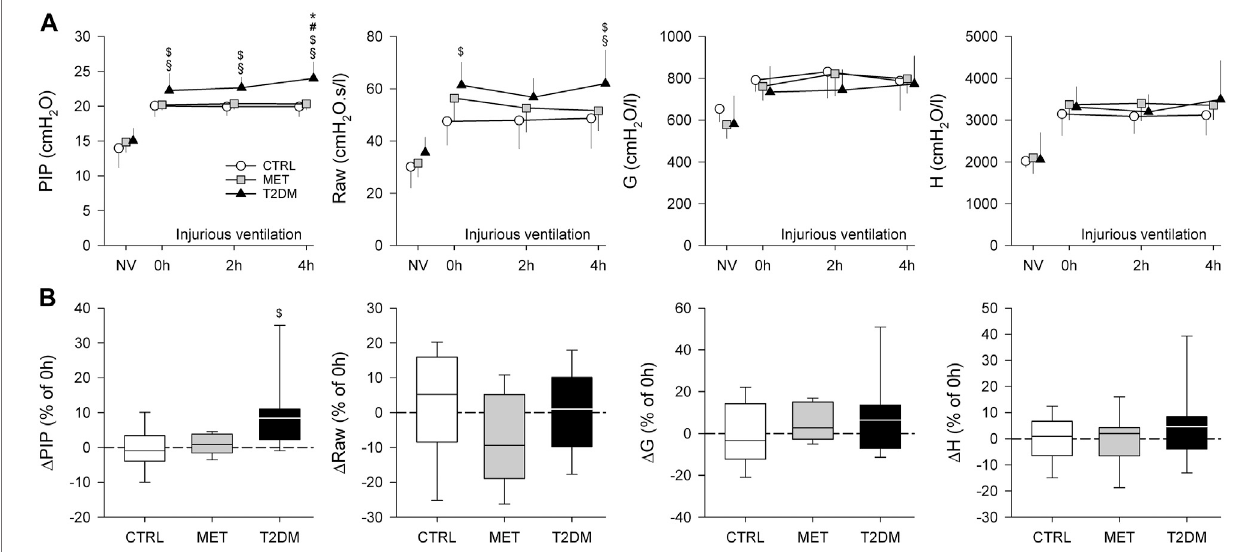
FIGURE 4 | Peak inspiratory pressure (PIP), airway and viscoelastic respiratory tissue mechanical parameters obtained during volume-controlled ventilation with physiological parameters (NV) and injurious ventilation in control rats (CTRL), in rats with metformin-treated type 2 diabetes (MET), and in rats with untreated type 2 diabetes (T2DM). (A) : Absolute changes in mean values ±standard deviation (SD). (B) : Changes after 4 h of injurious ventilation values relative to the values obtained at 0 h. * p < 0.05 vs. 0 h; # p < 0.05 vs. 2 h; $ p < 0.05 vs. CTRL; § p < 0.05 vs. MET. Abbreviations: PIP, Peak inspiratory pressure; Raw, airway resistance; G, tissue damping (resistance); H, tissue